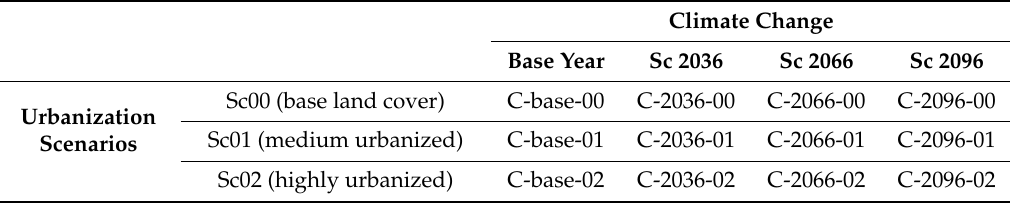
Table 9. The 12 combinations of climate change and urbanization